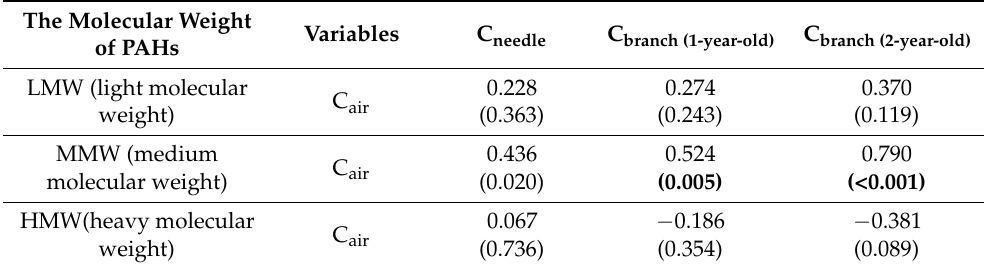
Table 3. R s values between air and tree components according to molecular weights of PAHs.